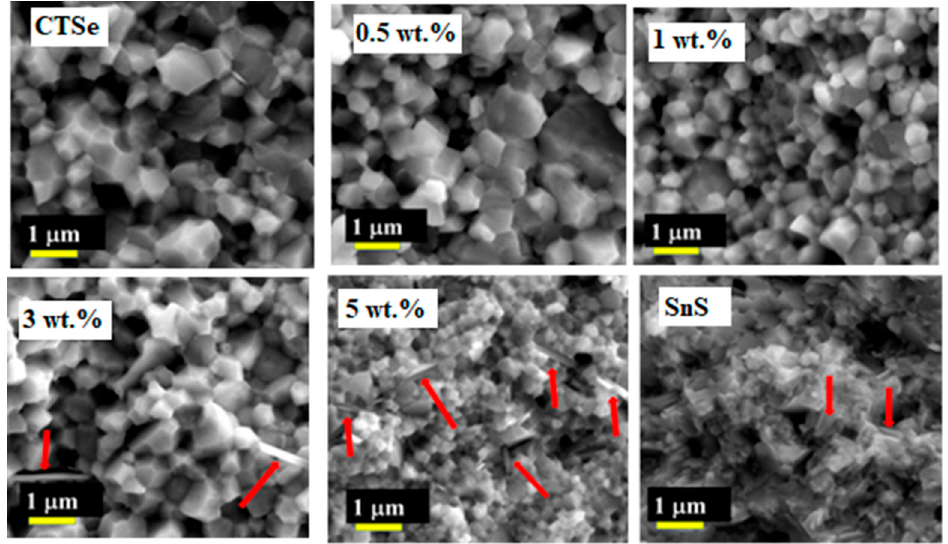
Figure 2. Field emission-scanning electron microscope (FE-SEM) images of the Cu 2 SnSe 3 , SnS, and Cu 2 SnSe 3 -SnS composite samples. The FE-SEM analyses were performed on non-polished surfaces of broken pellets. Red arrows indicate the SnS secondary phase within the CTSe matrix.